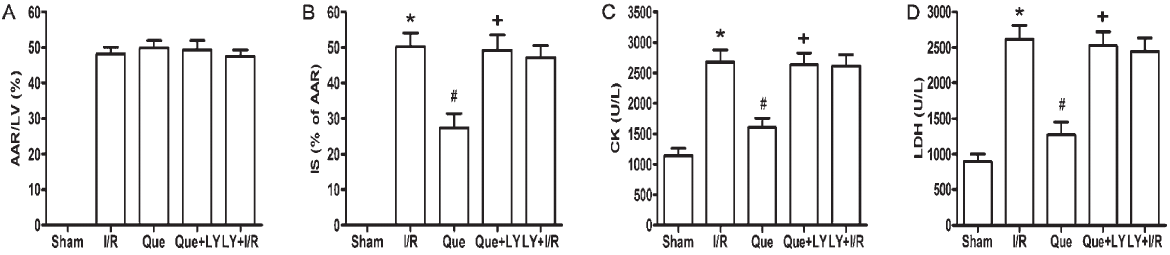
Figure 1. Effect of Que postconditioning on I/R-induced myocardial injury. A , AAR is reported as mean±SD percentage of the LV mass (n=5). B , Infarct size is reported as mean±SD percentage of the AAR mass (n=5). C , Effect of Que postconditioning on serum levels of CK (n=8). D , Effect of Que postconditioning on serum levels of LDH (n=8). Que: quercetin; I/R: ischemia/reperfusion; LY: LY294002; IS: infarct size; AAR: area at risk; LV: left ventricle; CK: creatine kinase; LDH: lactate dehydrogenase. *P , 0.05 vs sham group, # P , 0.05 vs I/R group, + P , 0.05 vs Que group (one-way ANOVA followed by the Bonferroni